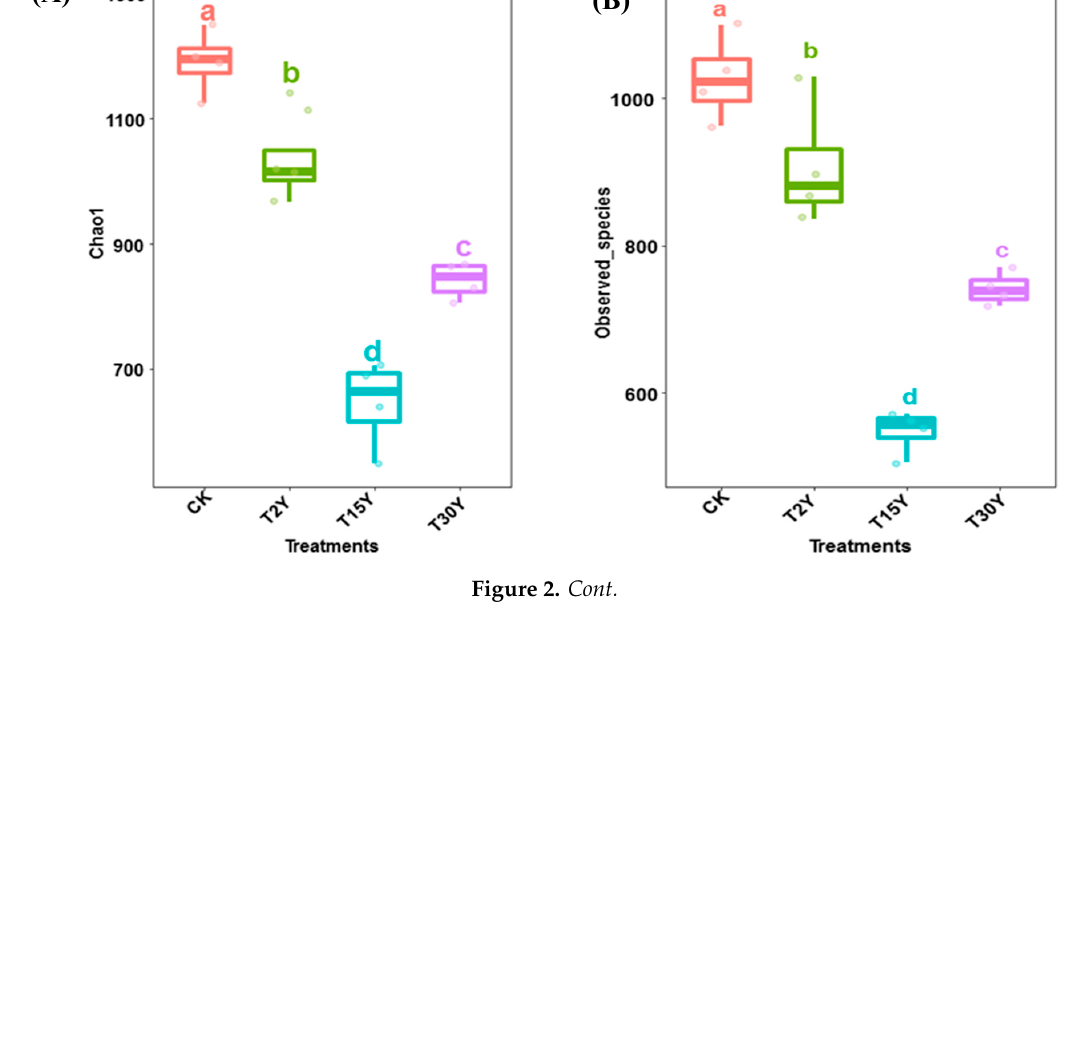
Figure 1. ( A ) Rarefaction curves with operational taxonomy unit (OTU) threshold of 97% sequence similarity and ( B ) Venn diagram for control and different age monoculture tea fields.